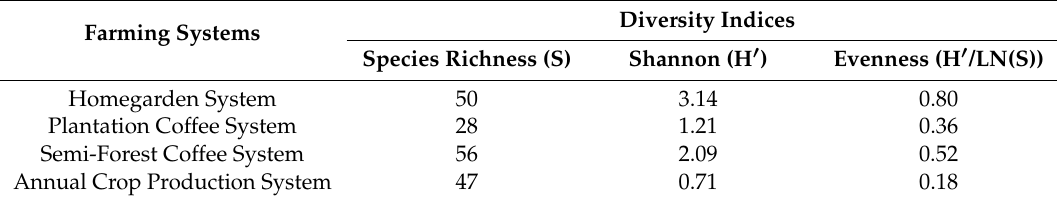
Table 1. Diversity indices of the major farming systems indicating species richness, Shannon diversity index and evenness of species within the systems, based on 10 plots of data for